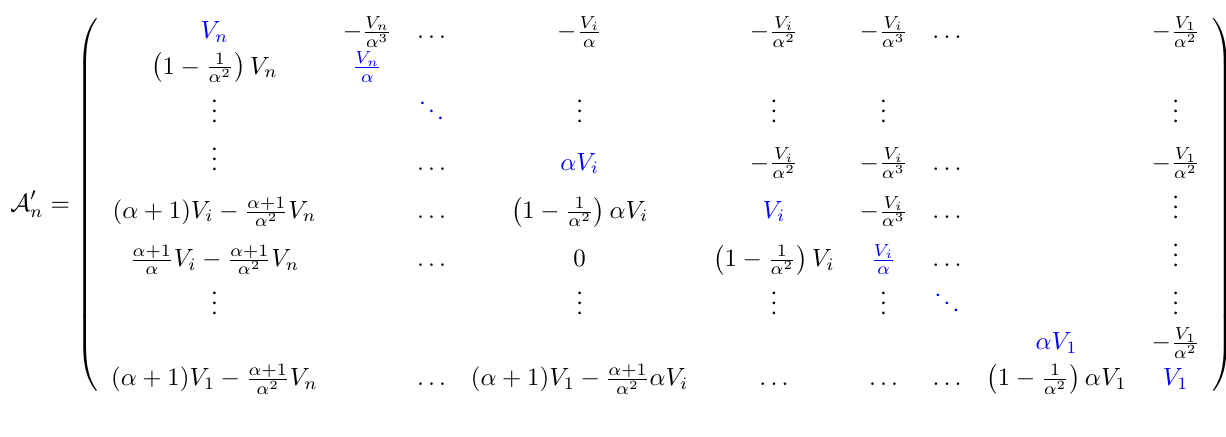
Figure 1. Extended evolutionary game matrix of the combined game A n and punishment P